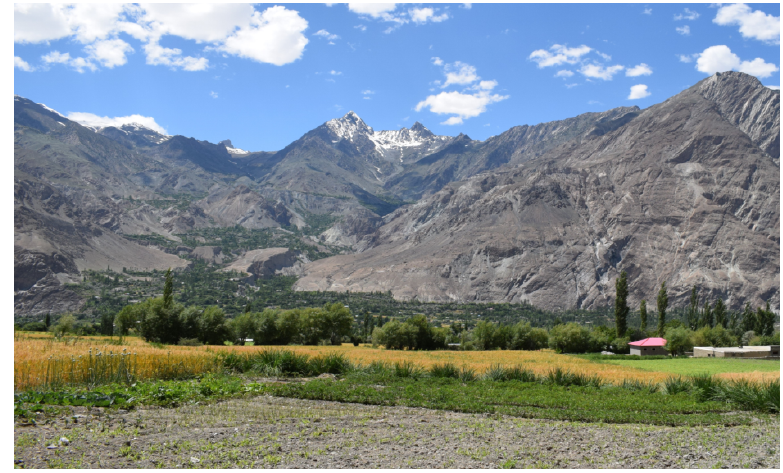
Figure 1. Landscape of the study area (an east-west view) with a wheat crop field. at Chatorkand, Ishkoman Valley, July 2019.